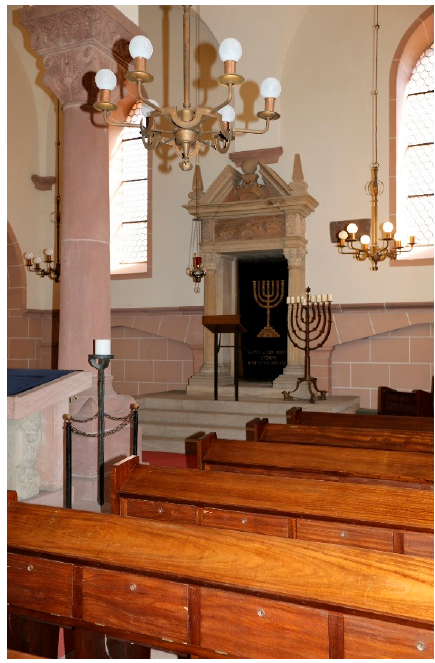
Figure 6. Worms (Creative Commons, Willy Horsch).